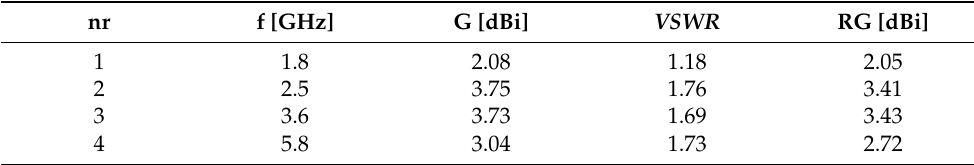
Figure 13. Three circle antenna optimized with P-EStra algorithm: ( a )—antenna geometry. ( b )— radiation pattern in x-z plane for on-body position. Table 6. Parameters of optimized three circle antenna.